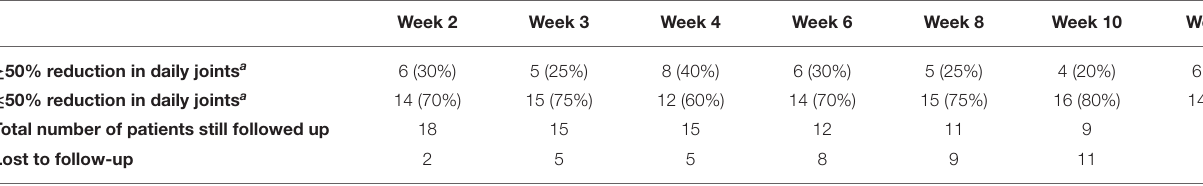
TABLE 2 | Change in primary endpoint 1.